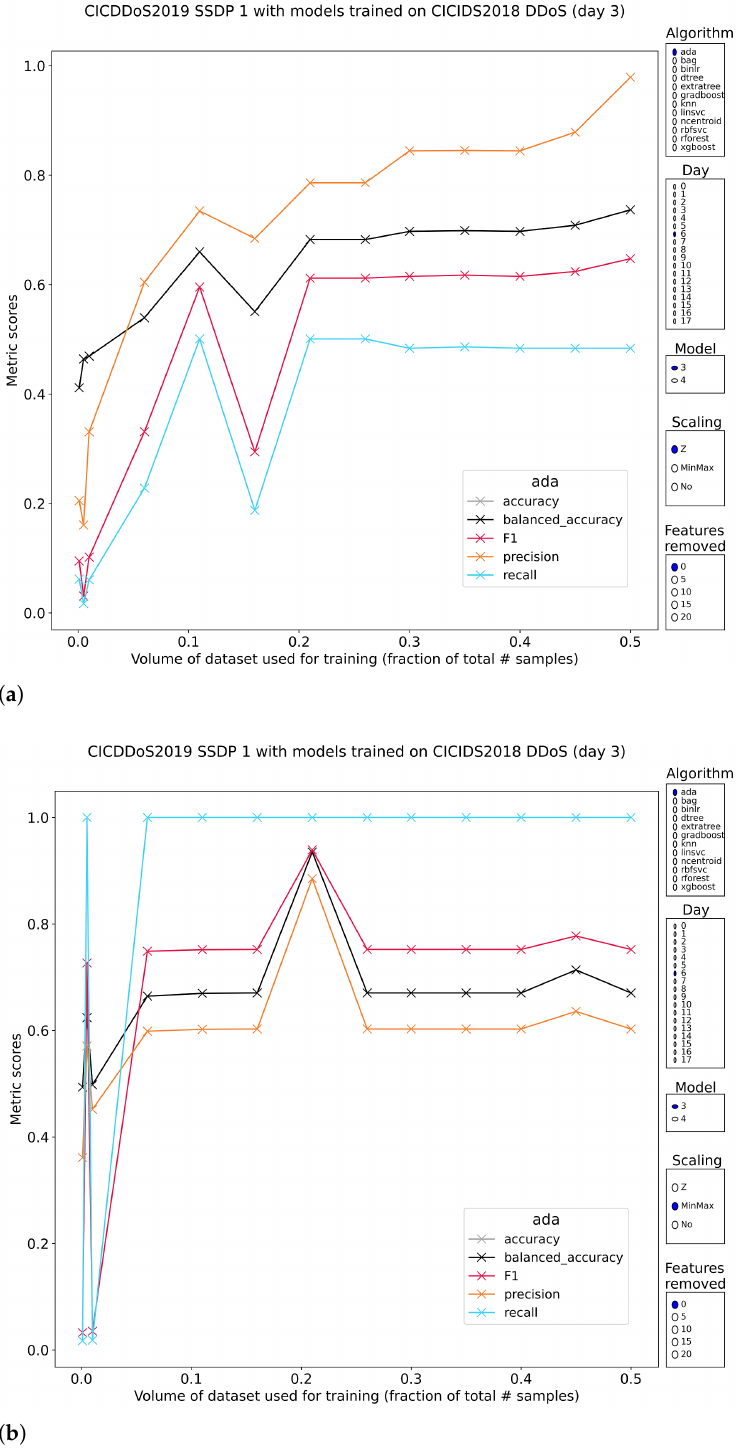
Figure 14. Feature scaling prior to training has a significant impact on performance in the interdataset case ( a , b ). The same methods did not show this weakness when just evaluating